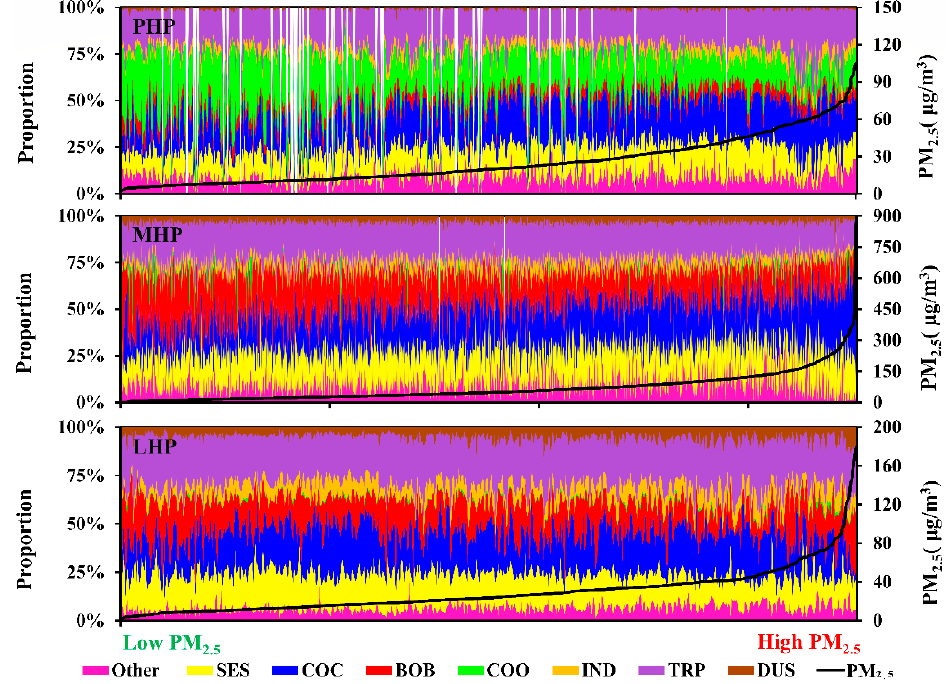
Figure 7. Evolution of main contribution as PM 2.5 concentrations increased in PHP, MHP and LHP.